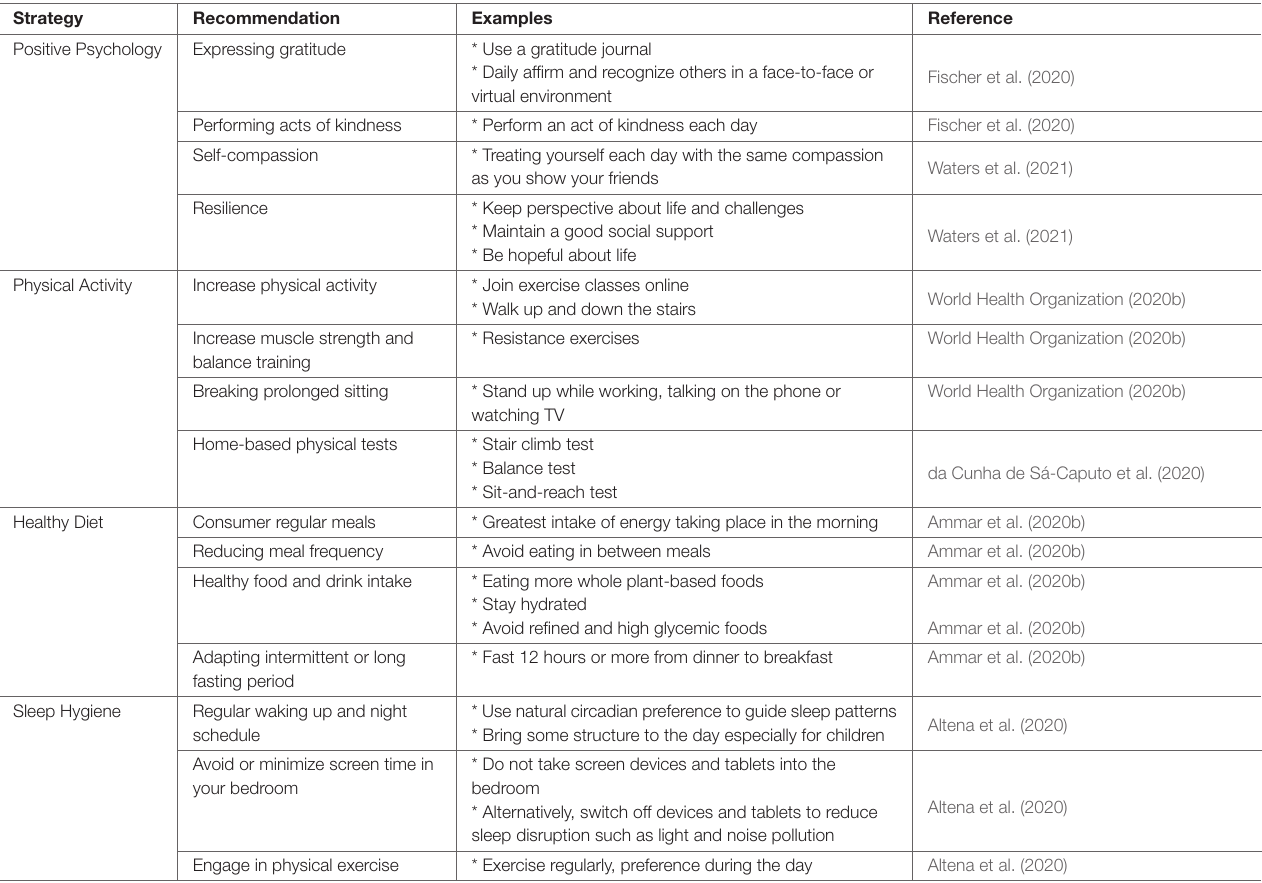
TABLE 1 | Practical Positive Psychology and lifestyle recommendations during COVID-19.